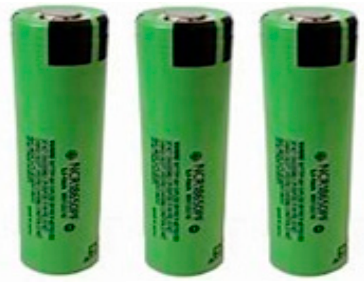
Figure 1. A cylindrical cell LiFePO 4 (A18650) used in this work. Table 1. Characteristics of the cell under investigation-18650 lithium-ion battery (LIB)